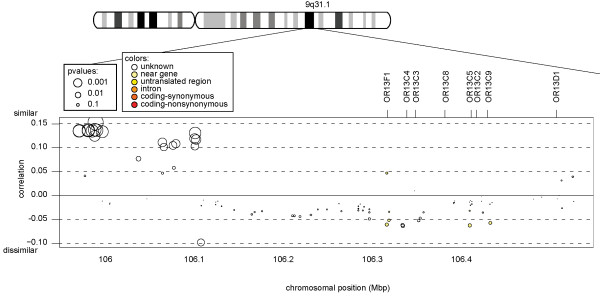
OR13 correlation plot on chromosome 9. A set of markers 200-300 Kbp upstream from 8 consecutive OR13 genes show excessive similarity between couples. Positions and gene symbols are from UCSC (build 36). The y-axis follows the convention of Figure 2.